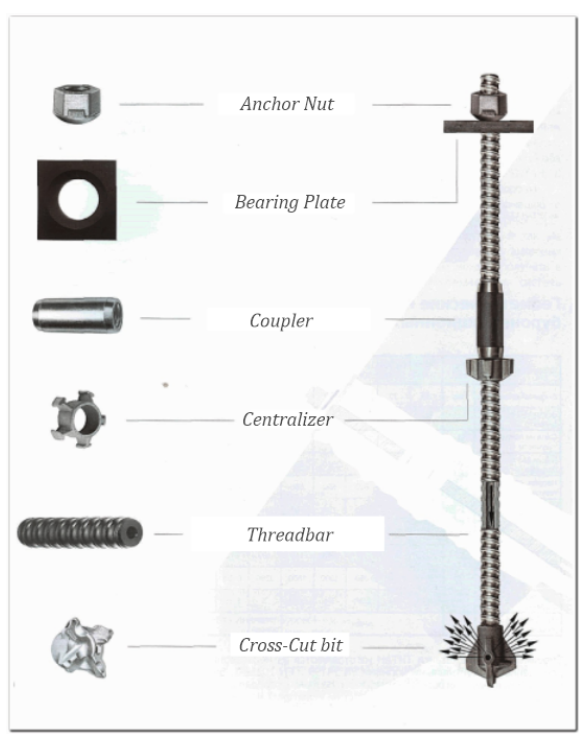
Figure 1. Structural elements of anchor piles “Titan” and